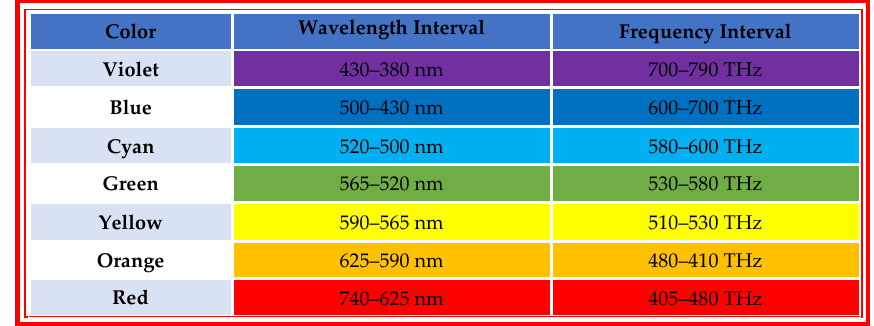
Figure 5. White light spectrum with its corresponding wavelength and frequency